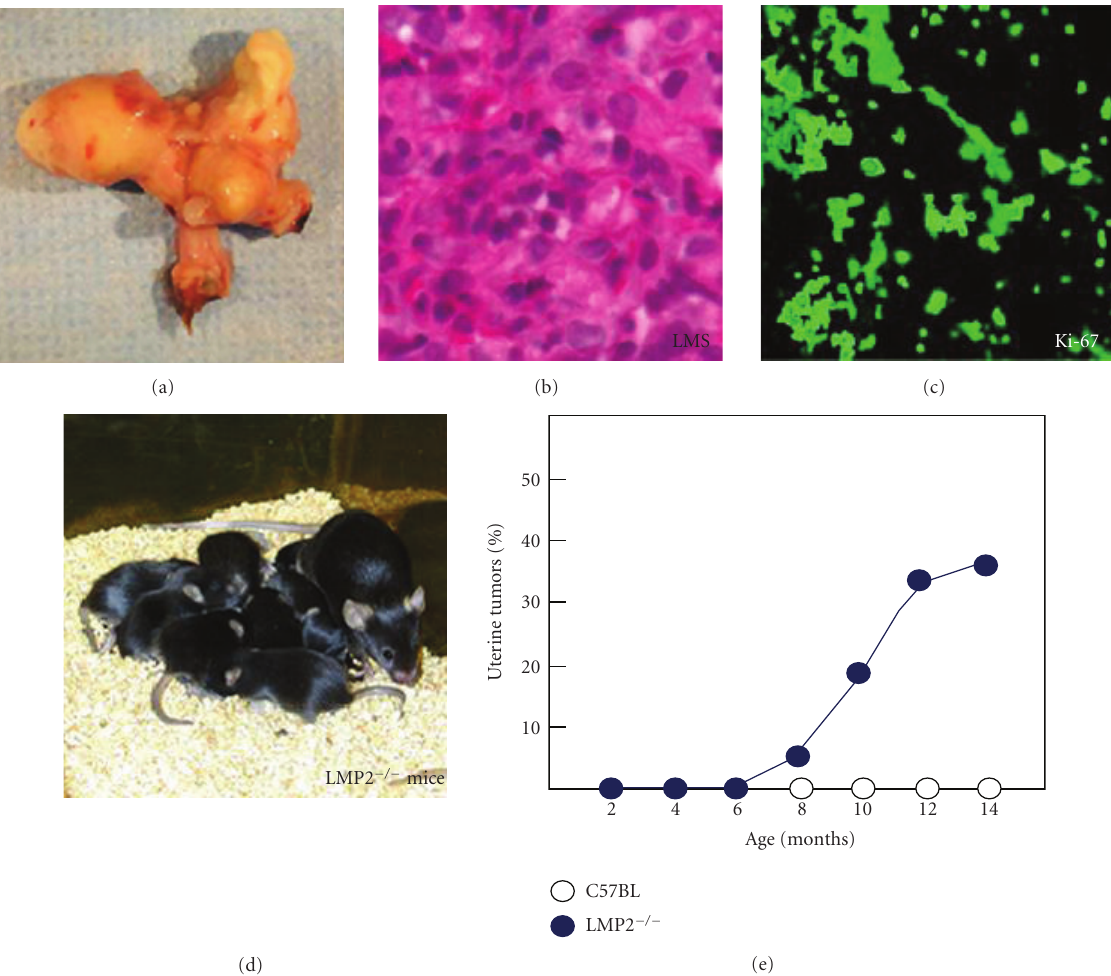
Figure 2: Histological findings of uterine leiomyosarcoma in LMP2-deficient mice. Histological findings of uterine LMS in LMP2-deficient mice ((a) to (c)). Among the histological findings of uterine LMS in LMP2-deficient mice, a cytoskeleton, which is characteristic of uterine LMS, is observed. ((b) and (c) magnification x400) Panel (e), in LMP2-deficient females, uterine LMS is observed at 6 months of age. The incidence at age 14 months is as high as 40% (e). The curve indicating the incidence of mouse uterine LMS is very similar to that indicating the incidence of human uterine LMS, which is observed after menopause. In mice with tumors of the uterus, significant weight loss is observed. Thus, a tumor that develops in the uterus is diagnosed as malignant, that is, uterine